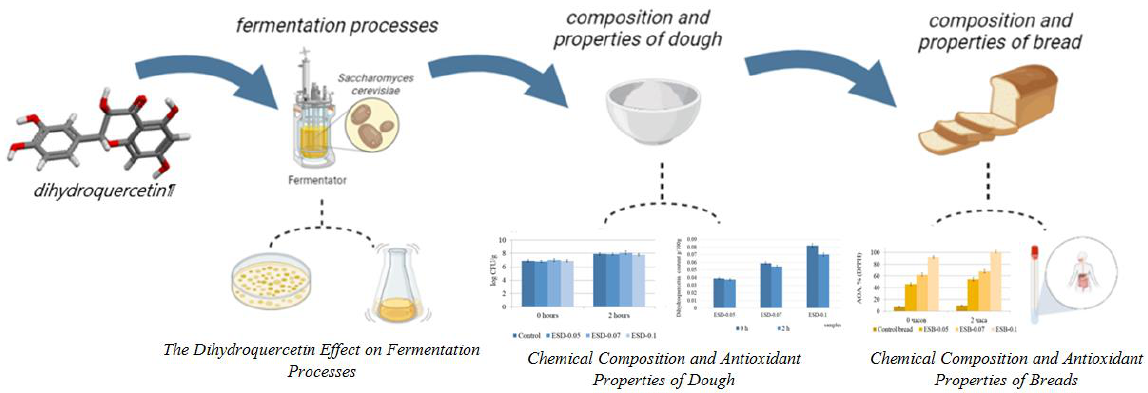
Figure 1. Generalized scheme of research.